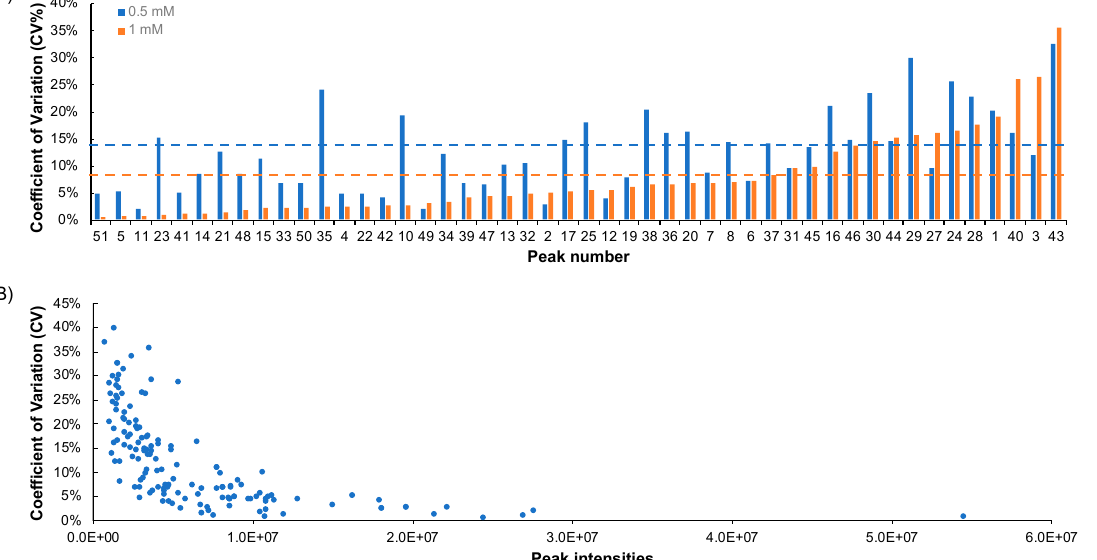
Figure 3. Variance of NUS intensity measurements. ( A ) Coefficient of variation (CV) for all metabolite resonances in Reference 1 at 0.5 mM (blue) and 1 mM (orange). The average CV is provided by the dotted lines. ( B ) Correlation between %CV and peak intensities for all metabolite resonances of Reference 1 at 0.5 mM and 1 mM.